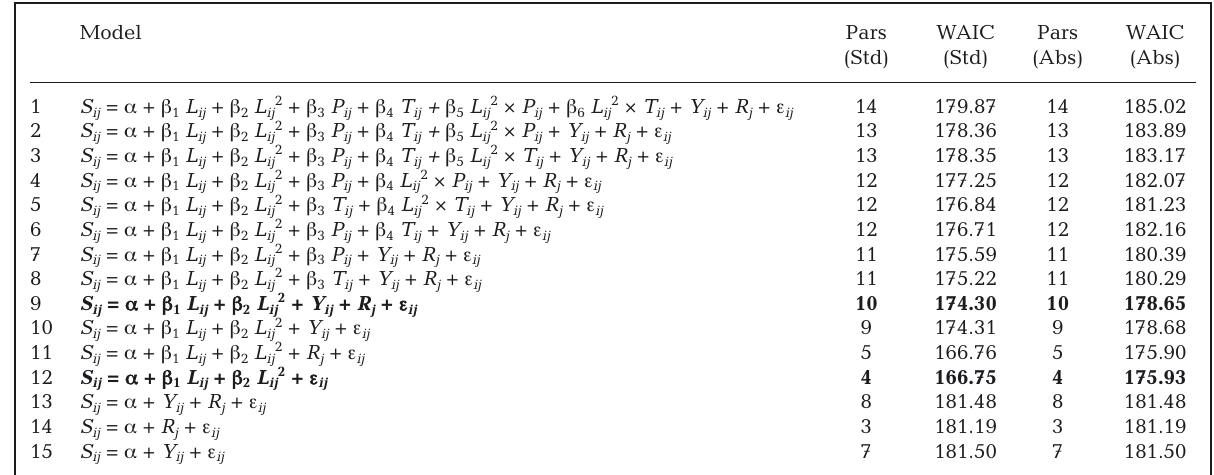
0. The model thus estimates an individual error term σ 2 for the trends in sea trout returns in each of the 5 vj is the random effect on the intercept study rivers j . R j of river. Table 2. Tested statistical models (see Section 2.2. for description of parameters) of salmon louse pressure (total number of lice on a farm site) and associated sea trout runs to nearby rivers. The model set was duplicated for standardised louse num- bers (Std: relative annual louse pressure by river) and absolute (Abs) annual louse numbers. Models had different numbers of parameters (Pars), and were compared using the Watanabe Akaike information criterion (WAIC). Note that models esti- mate an individual error parameter σ 2 vj for the temporal trend in sea trout returns in each of the 5 study rivers j (see Fig. 5). Reported models are shown in